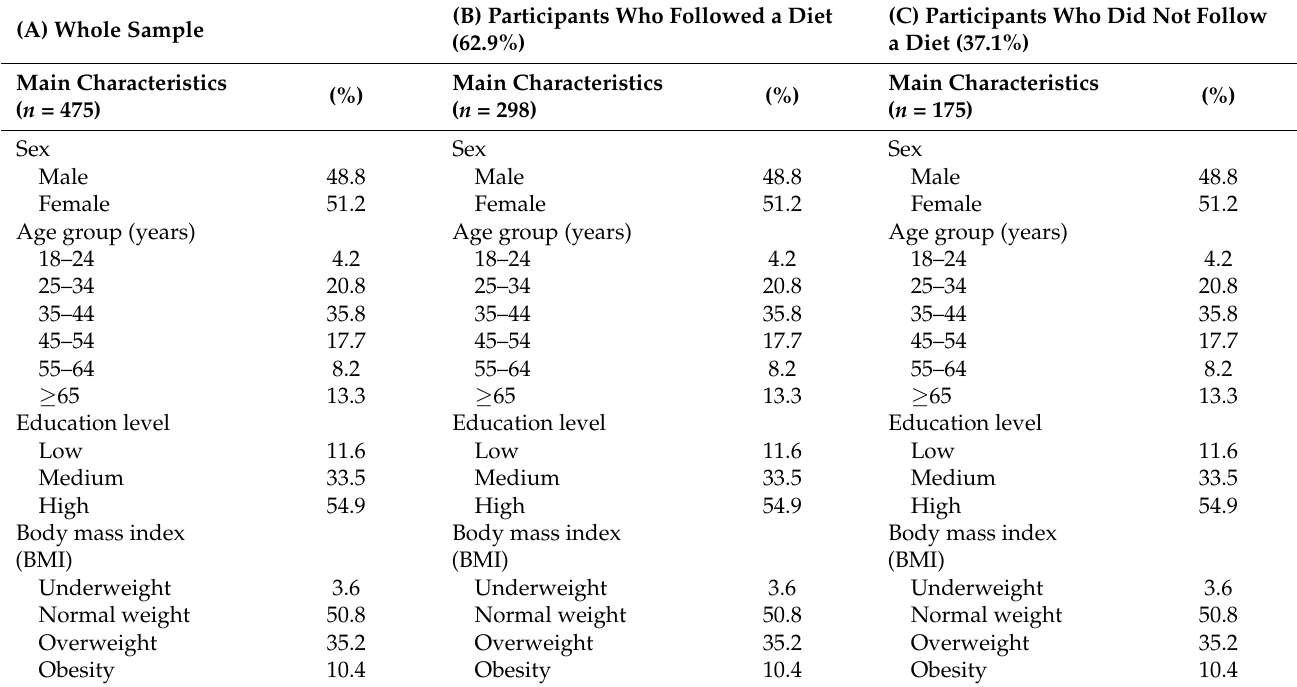
Table 1. Sociodemographic and other characteristics for the whole sample (A), participants who